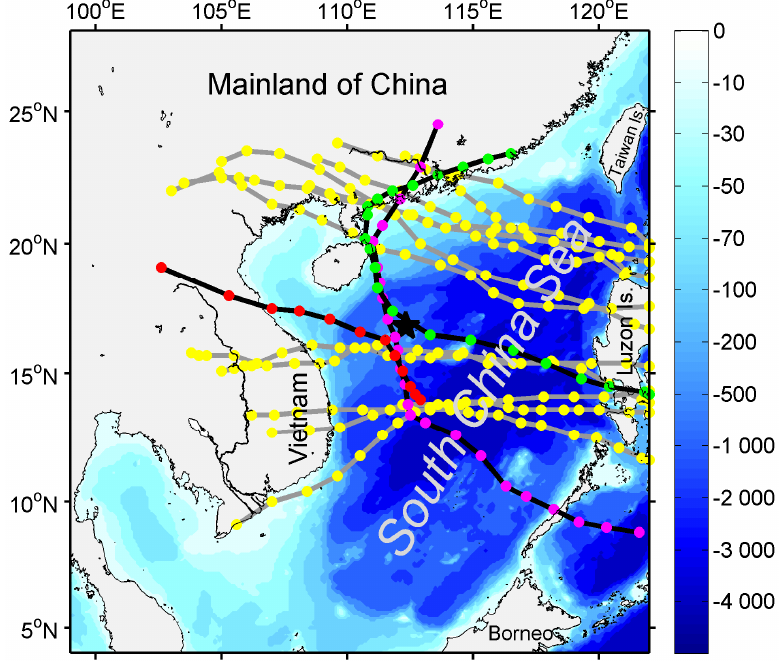
Figure 1. Bathymetry of the South China Sea (unit in m), the position of meteorological sensor (black pentagram) and 15 typhoons from 2001 to 2009. The tracks of typhoons Neoguri, Mekkhala, and Higos are denoted by magenta, red, and green dots, respectively. The trajectories of typhoons Yutu, Molave, Nuri, Koppu, Imbudo, Krovanh, Hagupit, Xangsane, Ketsana, Mirinae, Lingling, and Durian are denoted by yellow dots.